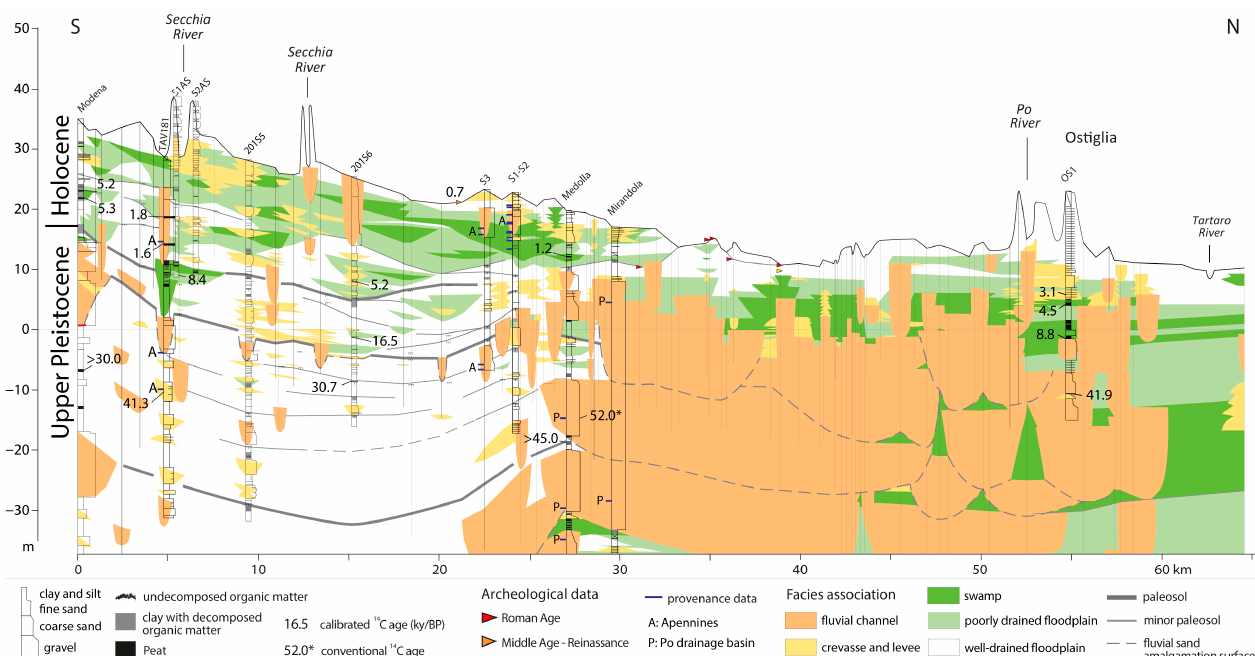
Figure 3. Late Quaternary stratigraphy of the Po Plain. Stratigraphic architecture of Upper Pleistocene and Holocene deposits along a south-north oriented stratigraphic cross section (modified after [14]). Location in Figure 1.